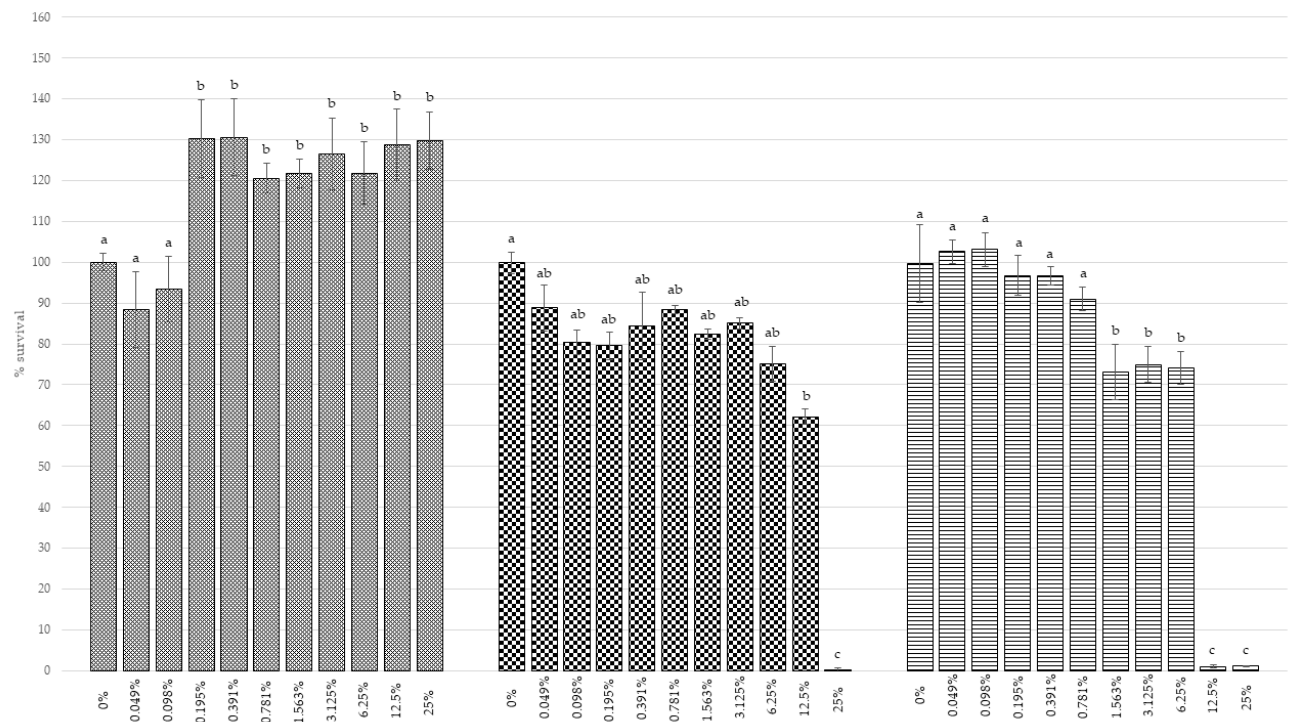
Figure 2. Antiproliferative activity after 48 h of treatment with RH tested on MCF10A, HL60, and Caco2 cell lines. The standard deviation is represented by black bars. Bars with different letters indicate a significant difference at p < 0.05 among cell lines, according to a one-way analysis of variance (ANOVA) for multiple comparisons applying the Tukey test.